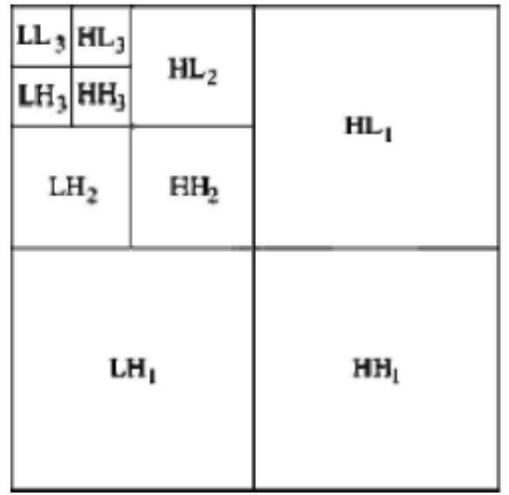
Fig. 2 Diagram of image wavelet decomposition.